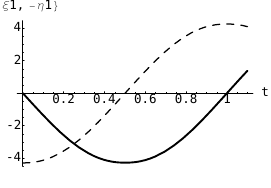
Figure 6. Another 2 -type so- lution of the problem